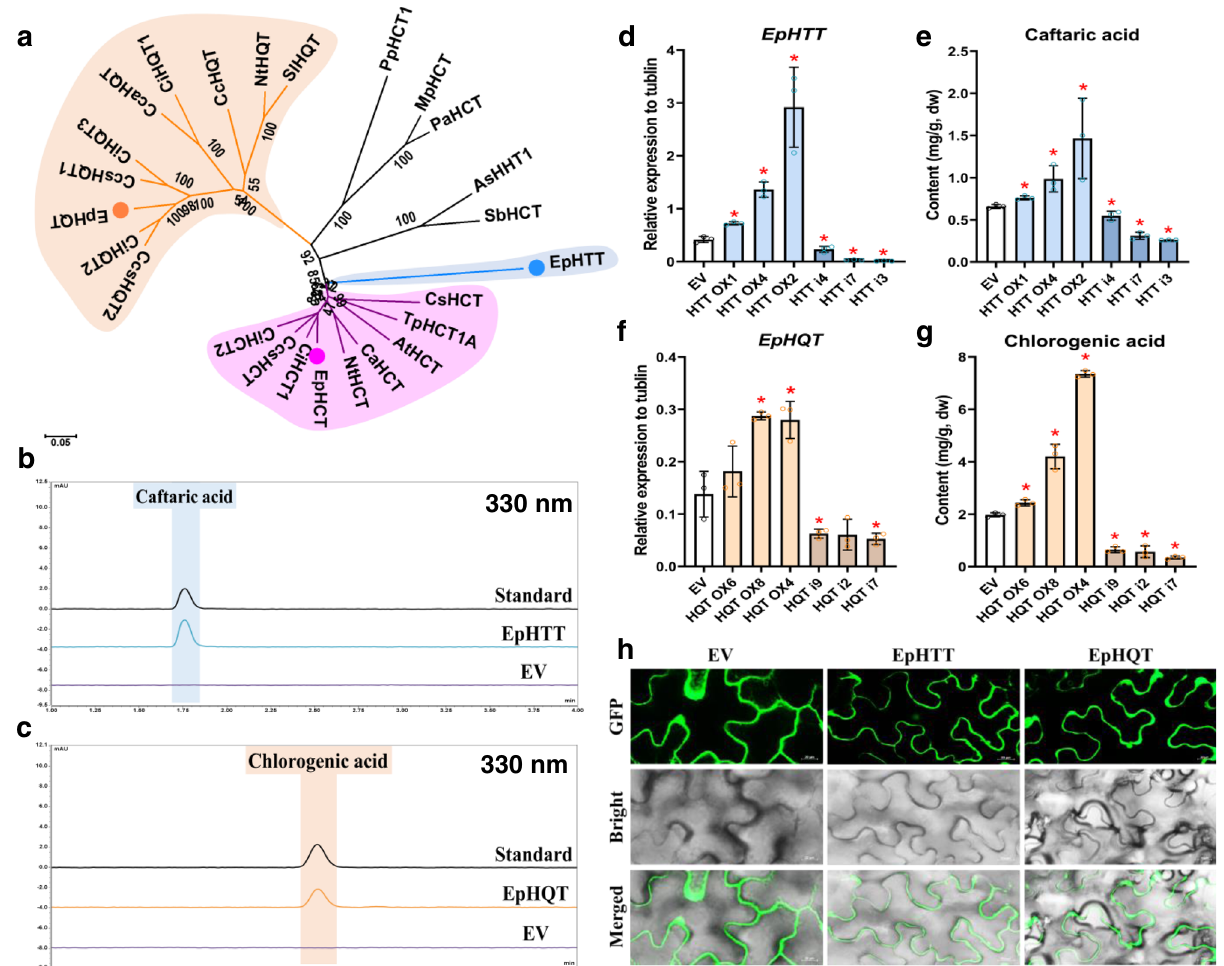
Fig. 2 Two cytosolic BAHD acyltransferases catalyze the synthesis of caftaric acid and chlorogenic acid. a Phylogenic analysis of EpHTT, EpHQT, and EpHCT with functionally identi fi ed BAHDs. GeneBank ID of the proteins used in the tree are listed in methods. The HQT and HCT clades are highlighted in orange and pink, respectively, and EpHTT is highlighted in blue. UPLC detection of caftaric acid and chlorogenic acid production by EpHTT ( b ) and EpHQT ( c ), respectively. d Relative expression levels of EpHTT and e caftaric acid contents in transgenic overexpression (OX) and RNAi (i) hairy root lines. f Relative expression levels of EpHQT and g chlorogenic acid contents in transgenic hairy root lines. Data are mean ± s.d. ( n = 3 biologically independent samples). * indicates signi fi cant difference from empty vector (EV) control line ( P < 0.05) analyzed by two-sided Student ’ s t -test. * P = 0.0013 (HTT